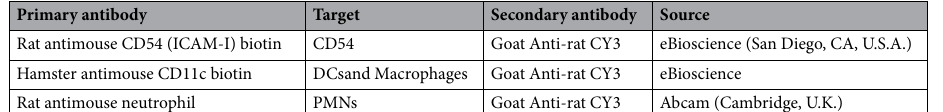
Table 1. Antibodies used for immunofluorescence staining. DCs, dendritic cells; ICAM, intercellular adhesion molecule; PMNs, polymorphonuclear neutrophils.